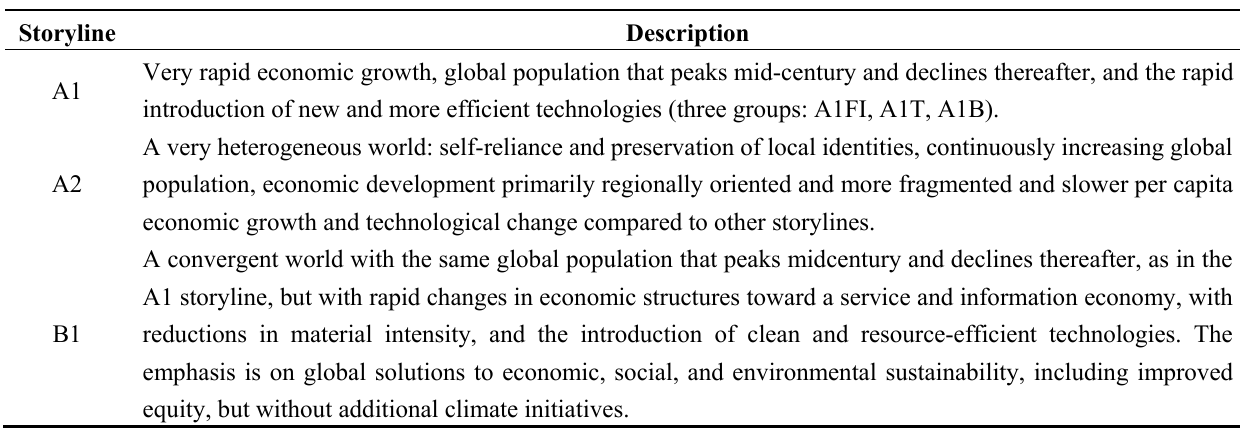
Table 2. Description of climate change scenarios